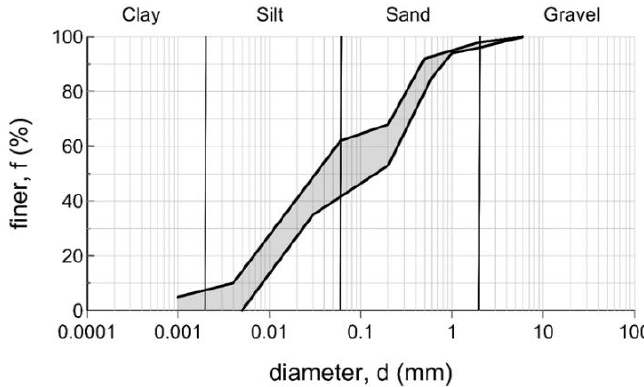
Figure 1. Physical model sketch with instrumentation.